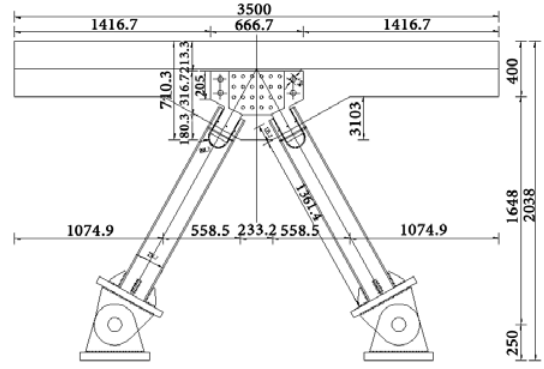
Fig. 3. Joint model structure and size, mm